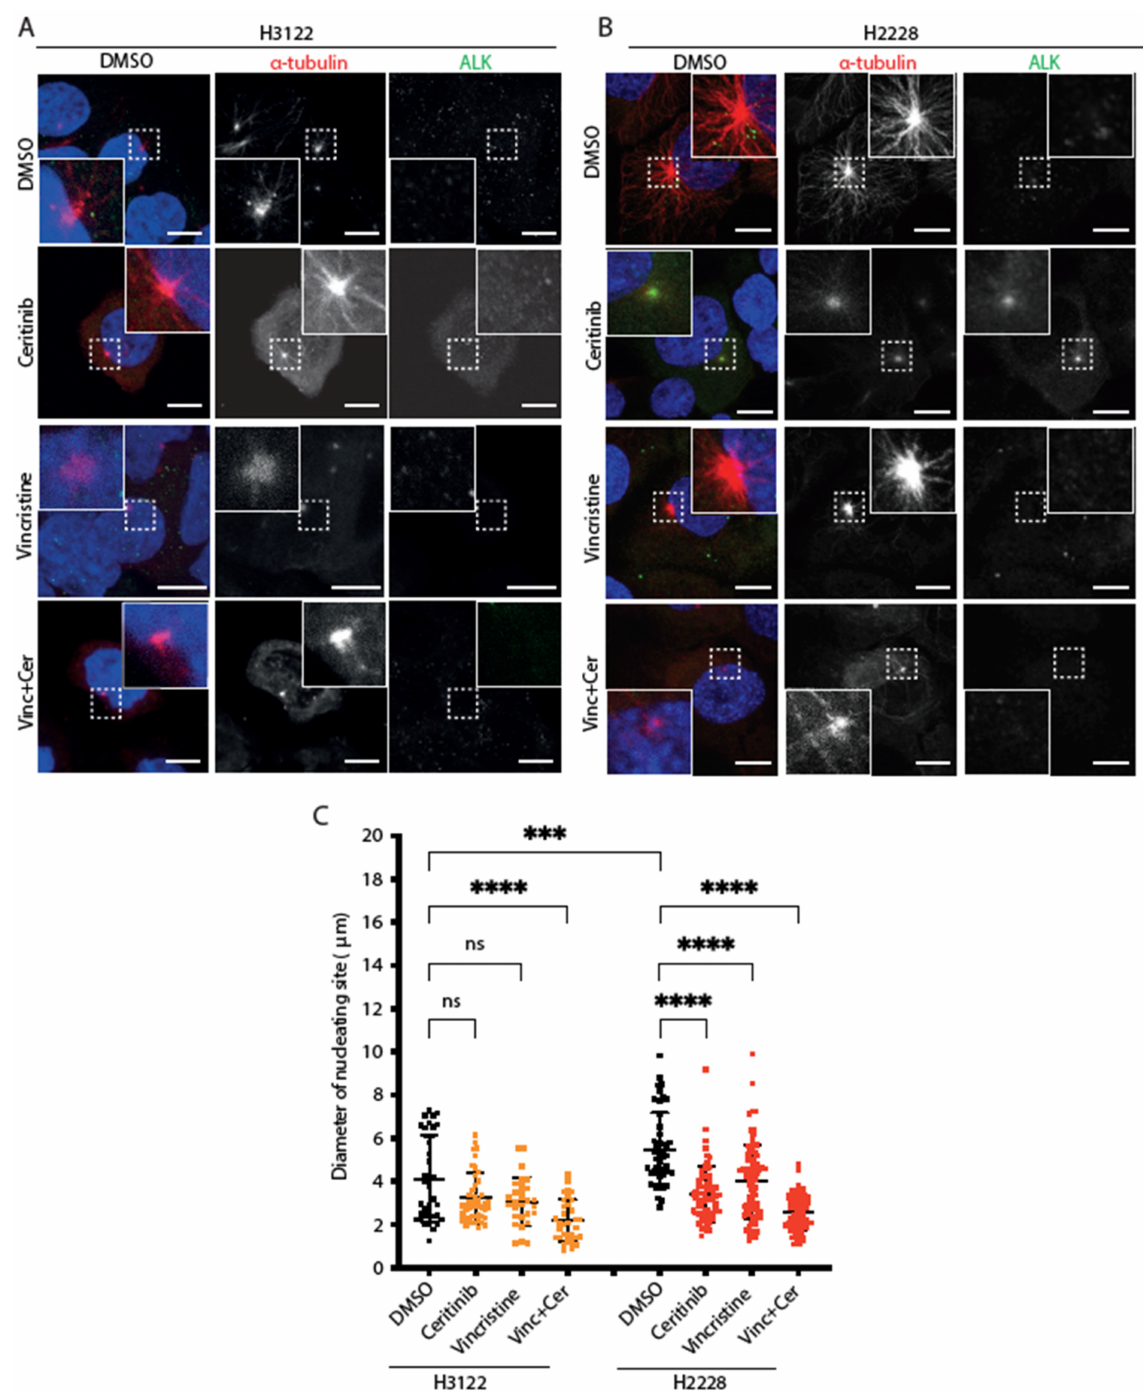
Figure 3. H2228 cells have higher microtubule nucleation capacity than H3122 cells. ( A , B ). H3122 and H2228 cells were treated with either DMSO, vincristine, ceritinib or in combination for 4 h, then incubated on ice for 30 min to depolymerise microtubules. The cells were released into warm medium for microtubule reconstruction for 5 min before being fixed and stained with anti-ALK (green), anti- α -tubulin (red), and DAPI (blue). Scale bars, 10 µ m; magnified views of a selected area are shown. ( C ). Dot plot shows the diameter of nucleating site per cell from ( A , B ). Data represent counts from >20 cells, n = 3. *** p < 0.001, **** p < 0.0001 in comparison to DMSO by one-way ANOVA. ns= not